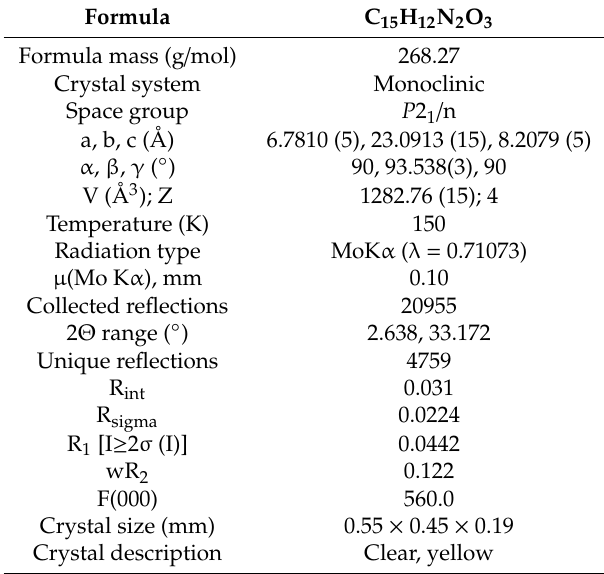
Table 1. Summary of crystal data.